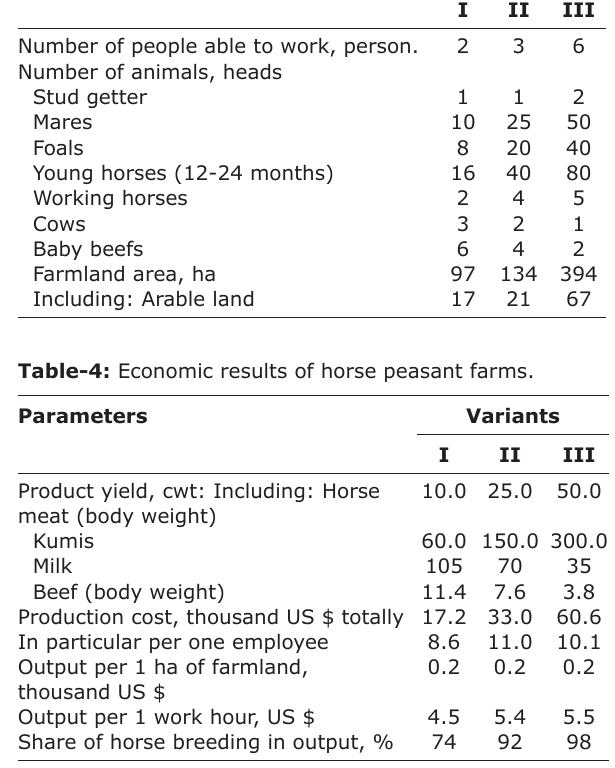
Table-3: Basic parameters of horse peasant farms.